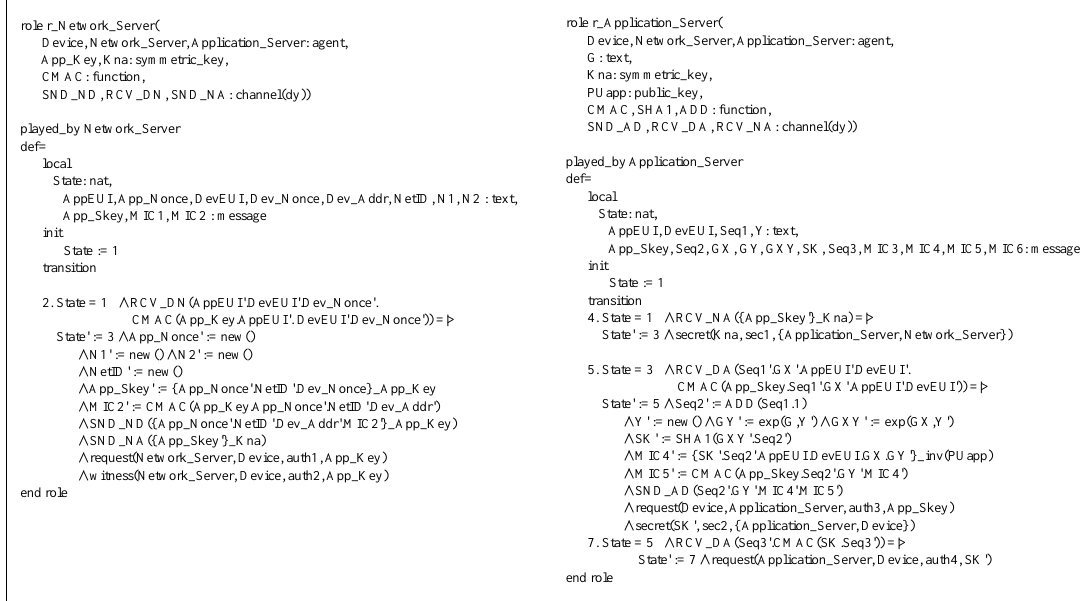
Figure 9. r_Network_Server role and r_Application_Server